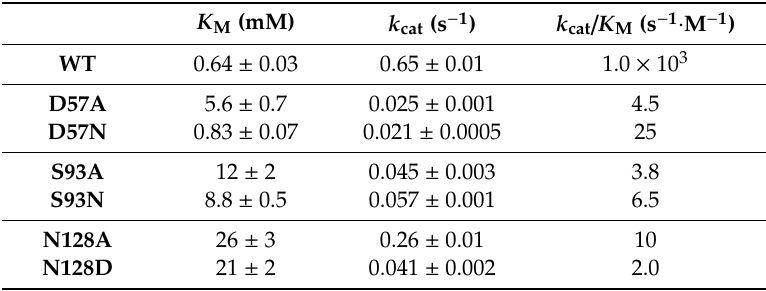
Table 1. Kinetic parameters of the mutations in the DPN–triloop